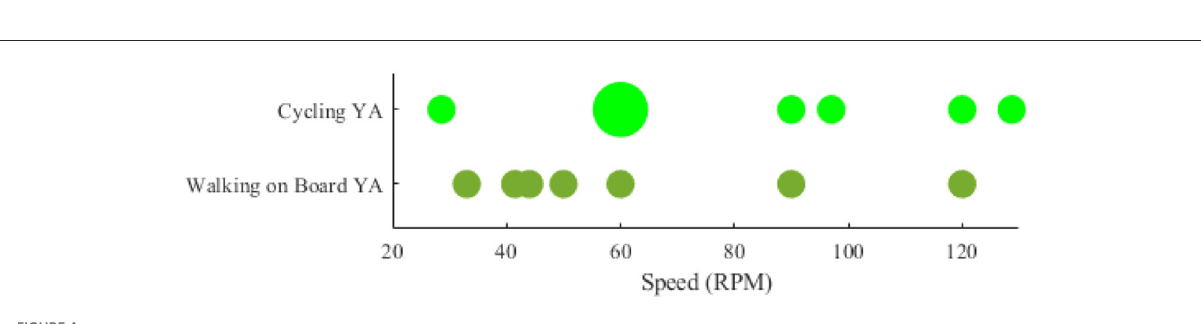
FIGURE4 Comparing locomotive intensity in two types of brain-body imaging tasks performed with different rotational speeds: 1) cycling 2) walking on a board with pedals. Only younger adults have been employed to perform these